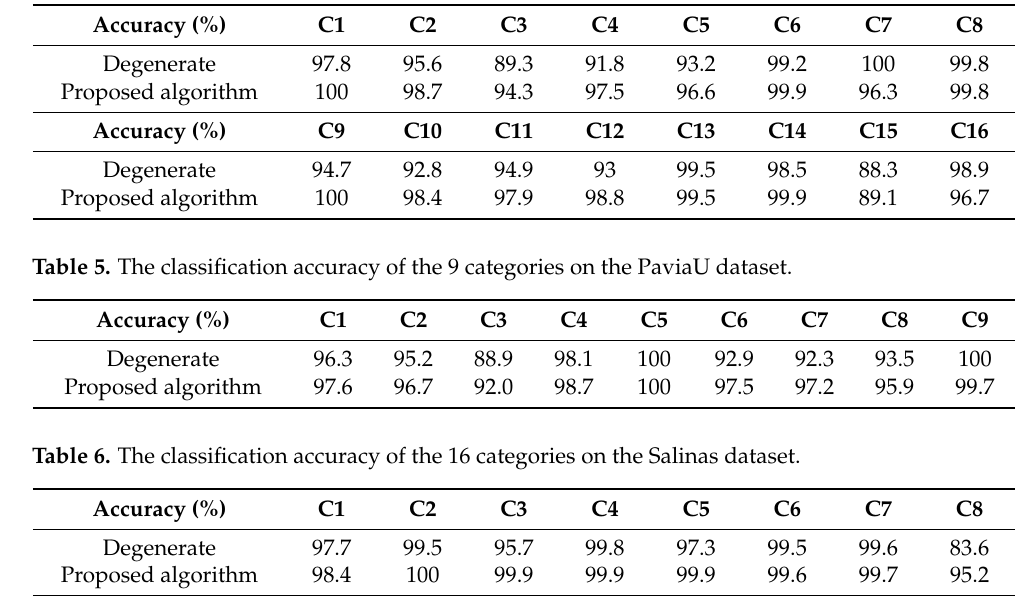
Table 4. The classification accuracy of the 16 categories on the Indian Pines dataset.